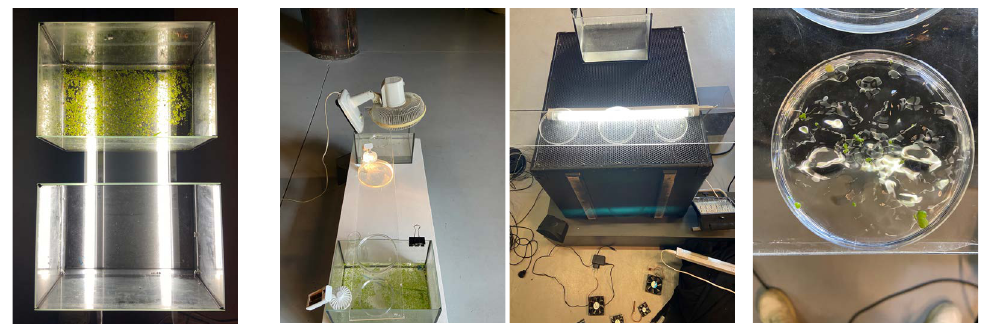
Figures 12 to 15: Vibration experiments. Fans, subwoofer and Lemna gibba . Water movement, disturbance and vibration at different